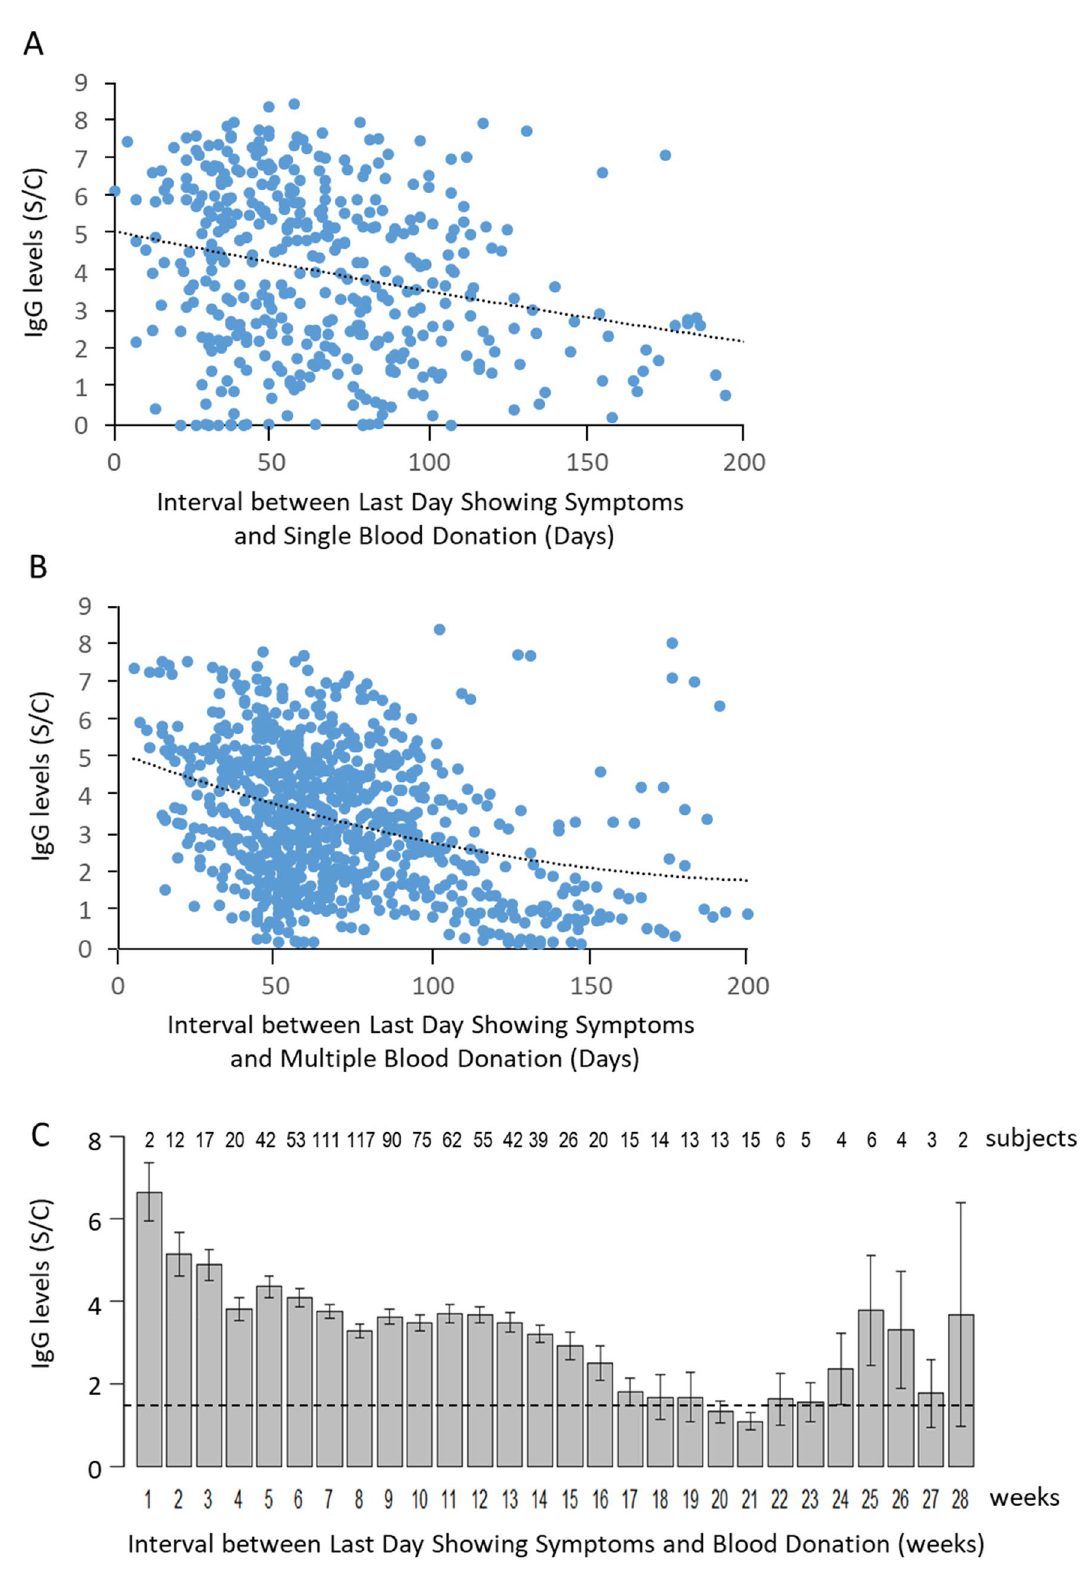
Figure 2. Reduction of average anti-N IgG levels in blood donated by COVID-19 positive subjects. ( A ) Anti-N IgG levels from subjects who donated blood once within 200 days after the last day showing symptoms illustrated a time-dependent decay. ( B ) All records of anti-N IgG levels in subjects who donated blood two or more times within 200 days after the last day showing symptoms are illustrated. Dotted lines represent the second order polynomial fitting curve. ( C ) The average anti-N IgG levels from blood samples donated within each week after the last day showing symptoms were calculated. The IgG levels were above 6 S/C at the first week and dropped to ~ 1.4 S/C at the 17th weeks. The dotted line represents the Abbott Architect positive/negative antibody threshold level at 1.4 S/C. Bars represent the standard error of